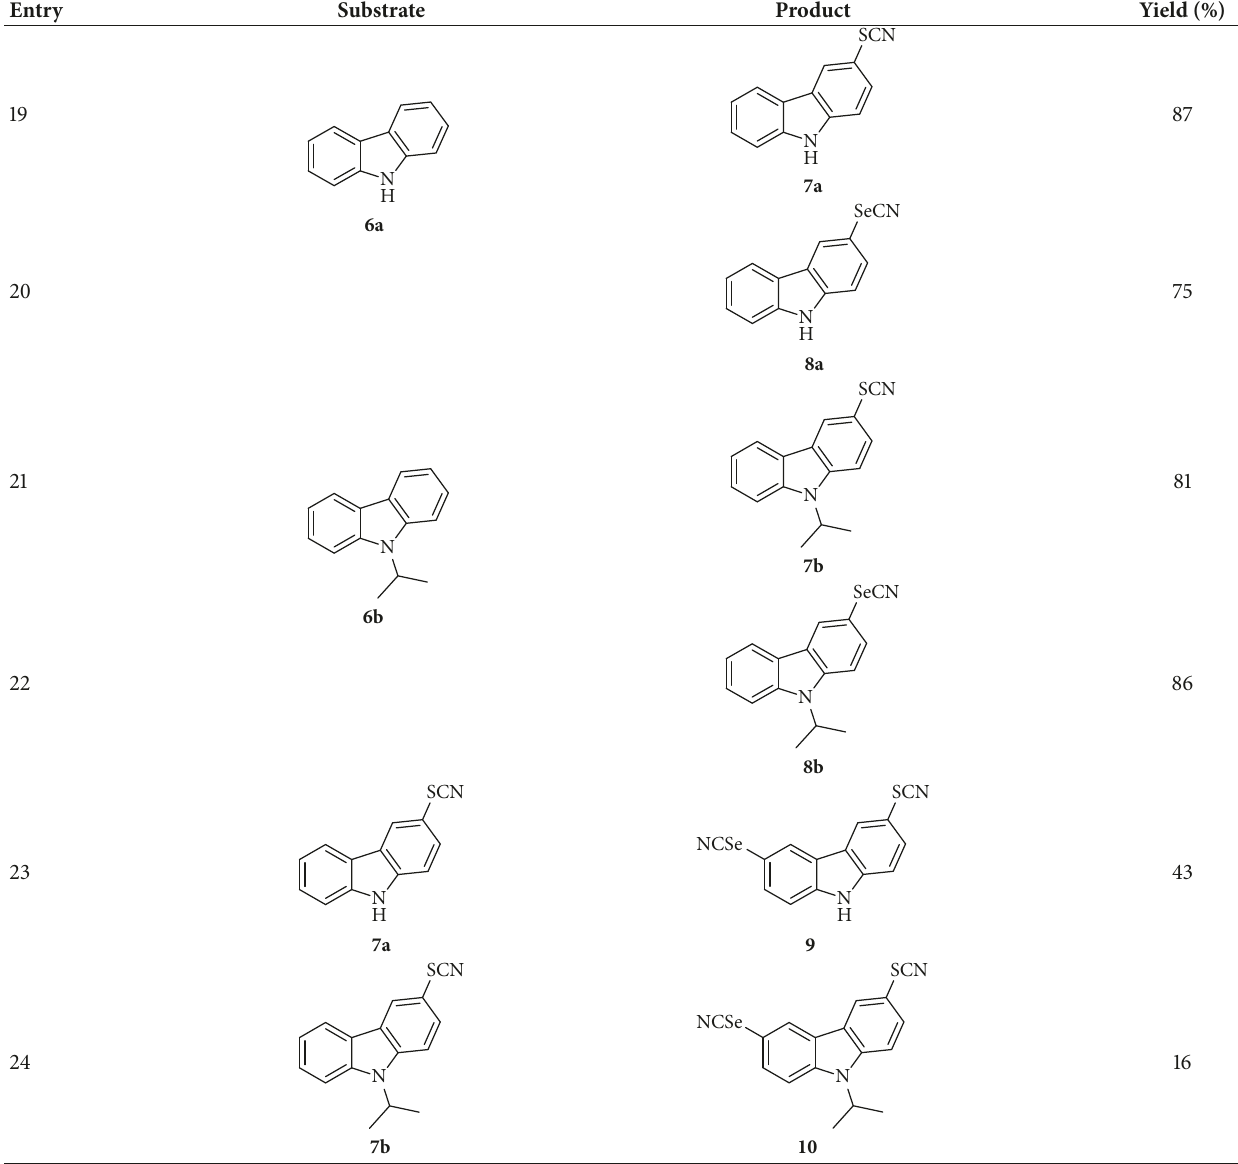
Table 2: Products resulting from thiocyanation and selenocyanation of the carbazole motif 6